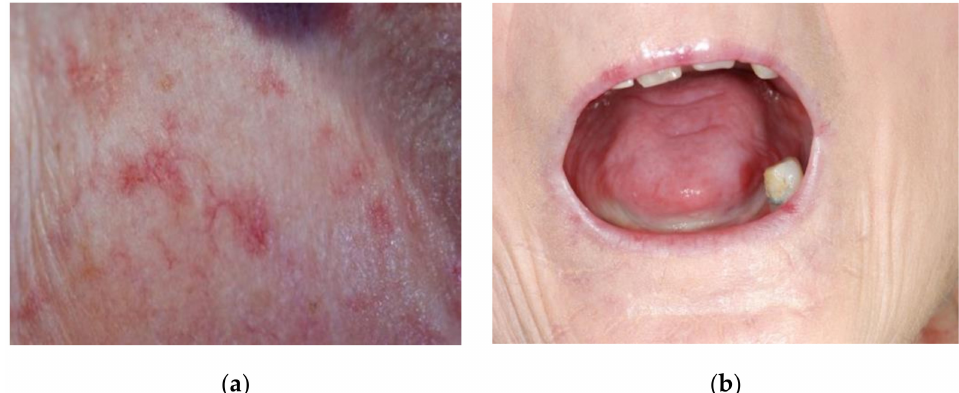
Figure 1. Typical orofacial manifestations of patients suffering from SSc: ( a ) perioral telangiectasia caudal of the right infraorbital margin; ( b ) Xerostomia, tongue smooth and atrophic.